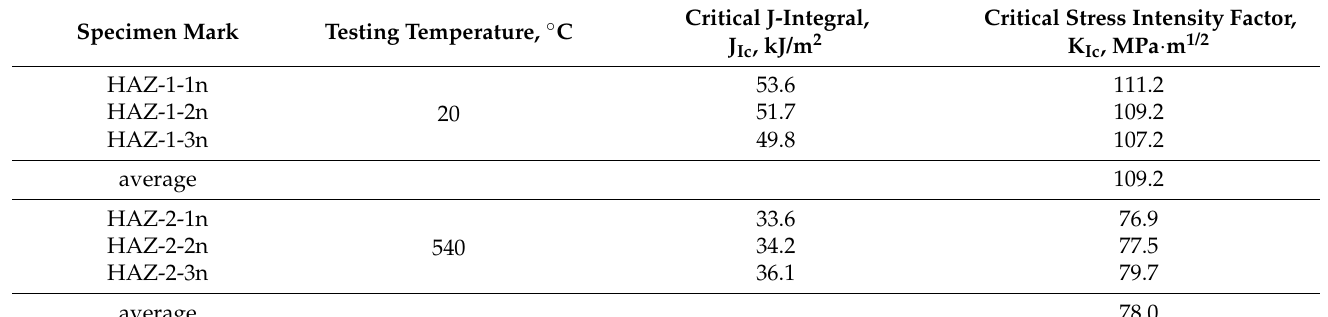
Table 15. Values of K Ic via J Ic for A387 Gr.